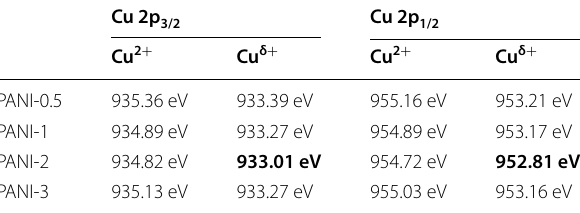
Table 1 Binding energies of Cu 2p spectrum for Cu-doped